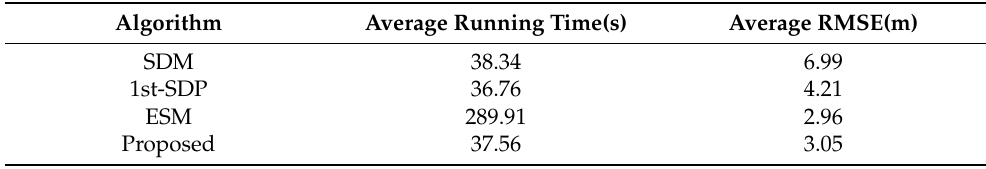
Table 1. Running time and root mean square error ( N = 25).